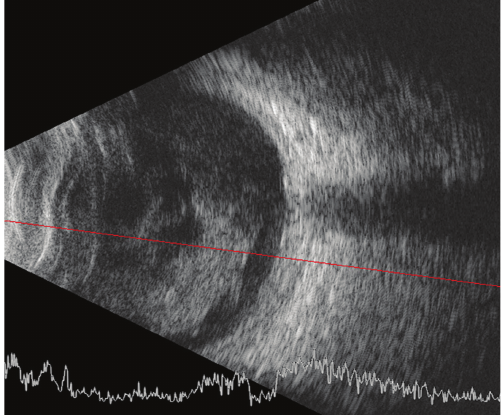
Figure 2: B-scan ultrasound demonstrating no signs of retinal deta- chment or obvious intraocular foreign body.